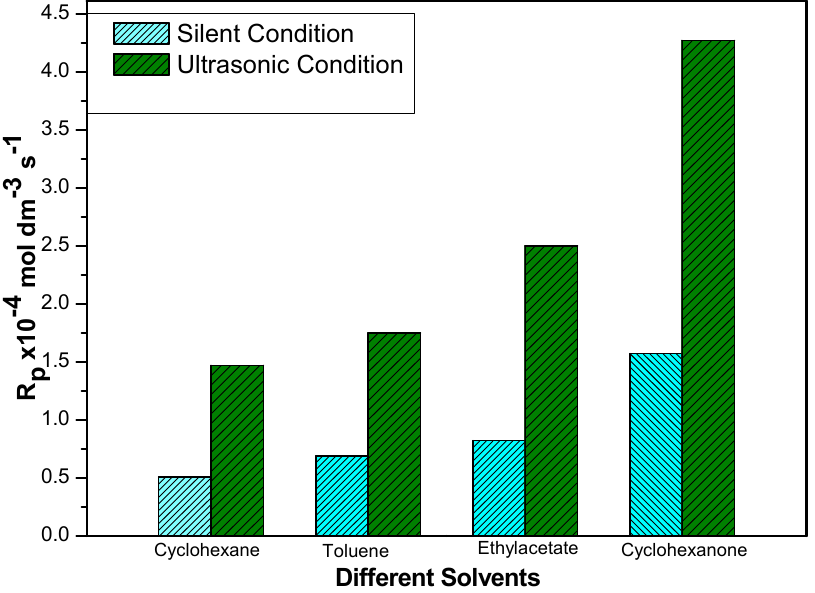
Figure 3. Rate of the polymerization of MABE under the US-MPTC and Silent-MPTC conditions in relation to the different solvents: 2.00